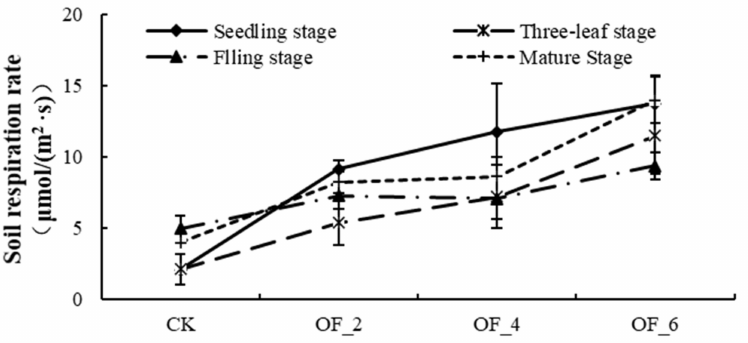
Figure 2. Effect of organic fertilizer application rate on soil respiration rate.